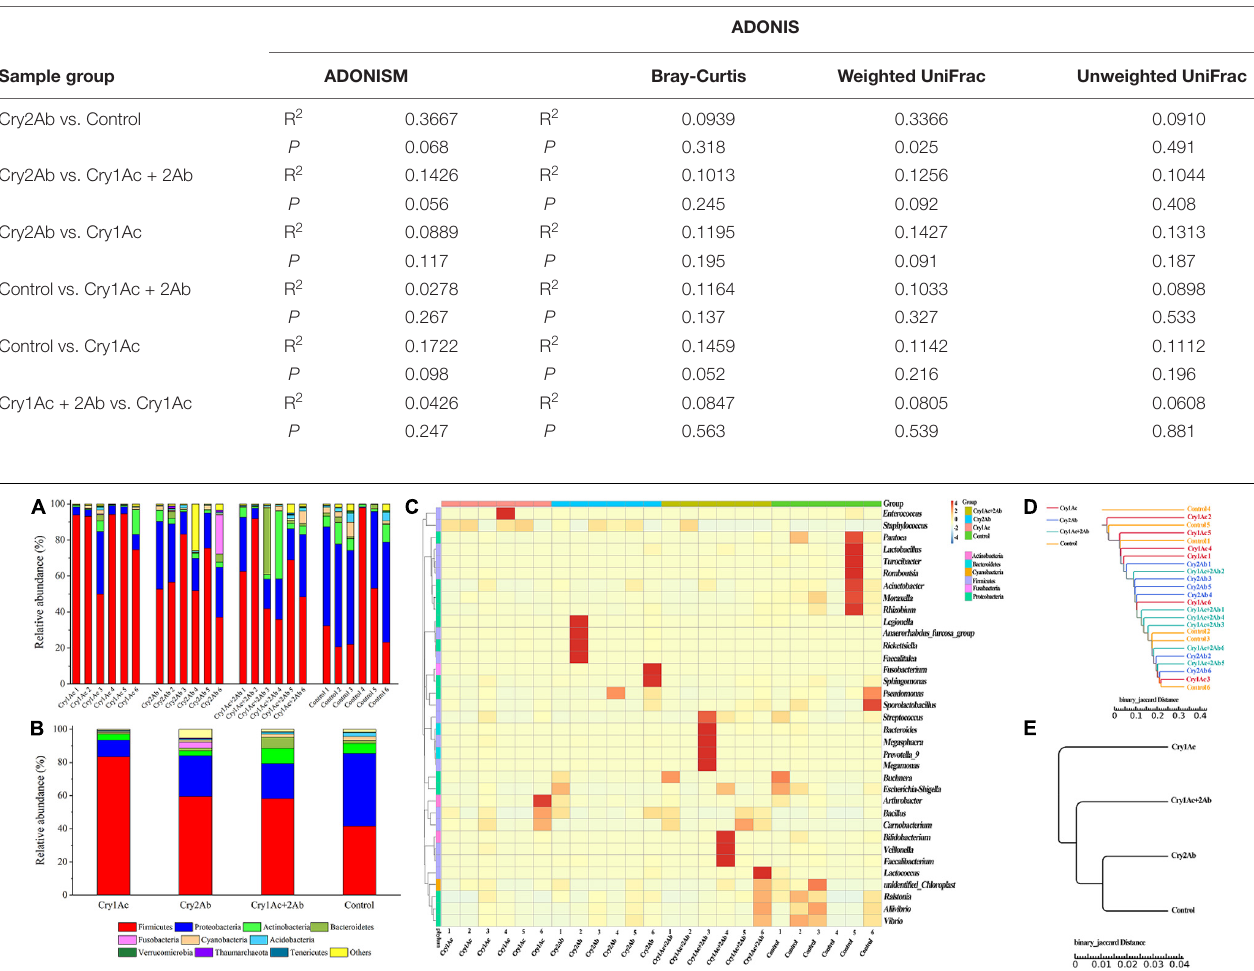
TABLE 1 | Significance test of differences in bacterial community in P. japonica by ANOSIM and ADONIS.